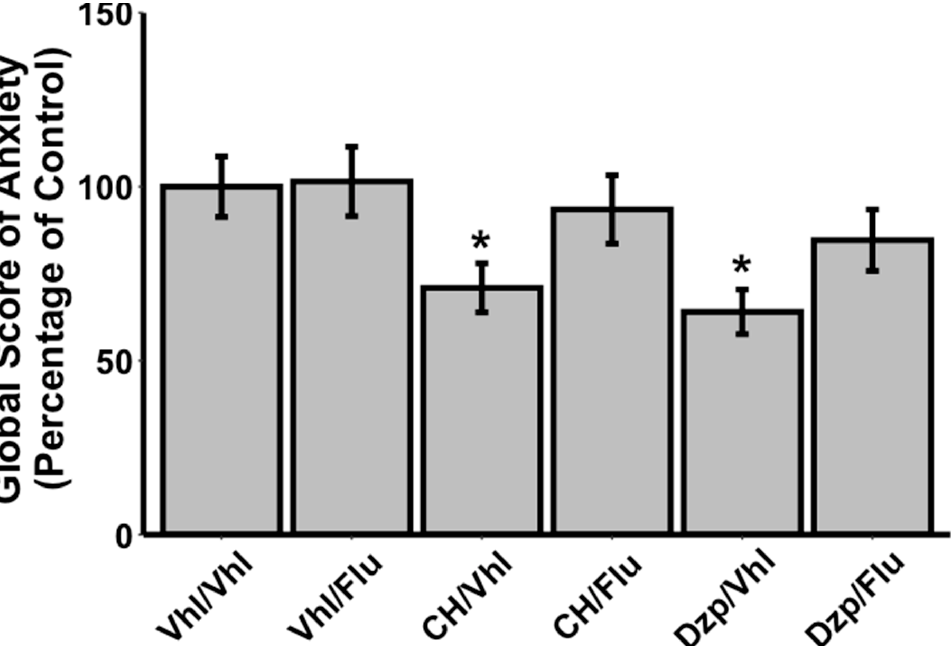
Figure 2. Effects of flumazenil (10 mg/kg, i.p.) on CH (15 mg/kg, oral) anxiolytic action in a conditioned defensive burying model in rats (n = 11–15 / group). Data are mean ± SEM. * Indicates signif- icant differences between the experimental group and the Vhl/Vhl group (Mann–Whitney U-test, p < 0.05). Vhl, vehicle; Flu, flumazenil; CH, tryptic hydrolysate of bovine α s1 -casein; Dzp, diazepam.